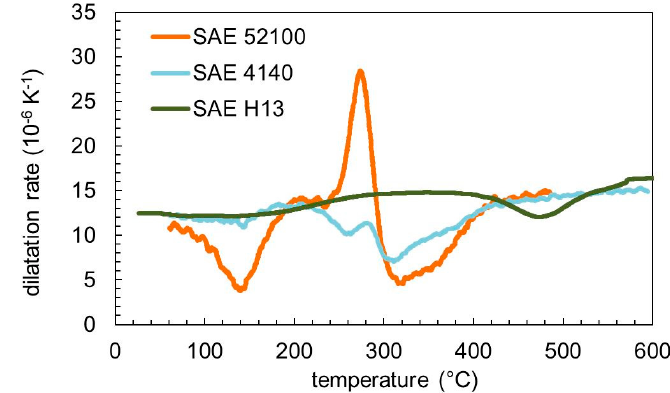
Figure 4. Dilatation rate for the three used steels tempered with a heating rate of 5 K min − 1 .